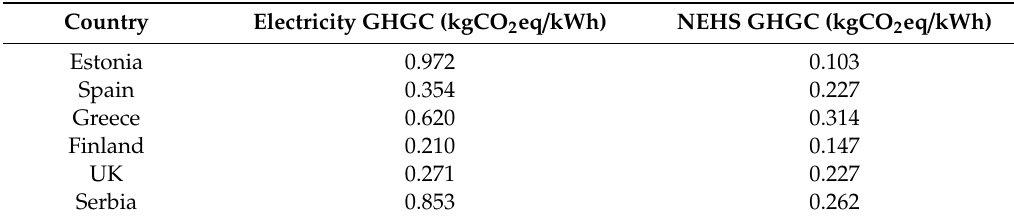
Table 6. Summary table for the obtained greenhouse gas (GHG) emission coe ffi cient (GHGC) of the di ff erent countries’ electricity mixes.